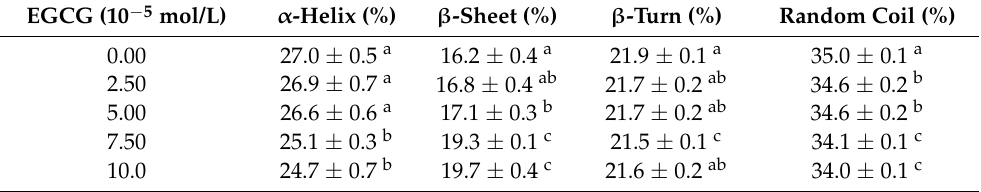
Table 3. Secondary structure fractions of PPI with different EGCG